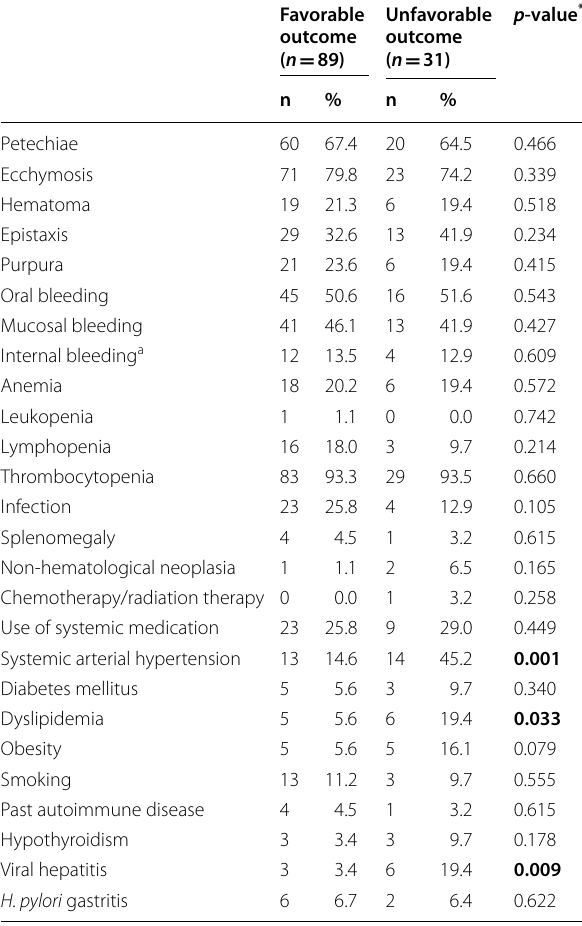
Table 2 Association between clinical parameters and evolution in 120 patients with